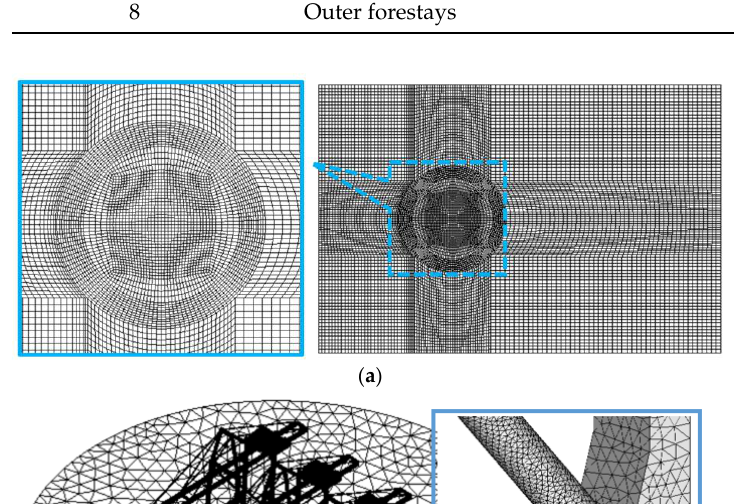
Figure 7. Boundary conditions of the computation domain. The mean drag coefficient values for the boom-down crane in the wind tunnel test are shown in Figure 9. For comparison, the results of Kang and Lee’s [ 16] wind tunnel test with the pow-law exponents of 0.143 and 0.1 are also demonstrated in the figure. The results obtained in the current study are in good agreement with previous investigations. The most unfavorable azimuth is 75° for the boom-down state in the wind tunnel tests, which also corresponds with the conclusions drawn by Kang and Lee [16]. Additionally, the wind force of each member was obtained and validated by wind tunnel tests, and the results were applied when calculating the wind-induced response. Moreover, the force and moment coefficients of CFD simulation in all cases were compared with that of the wind tunnel tests to check the accuracy. As shown in Figure 10, the force coefficient of 3# crane in case 3 was demonstrated and showed that the results agreed well.